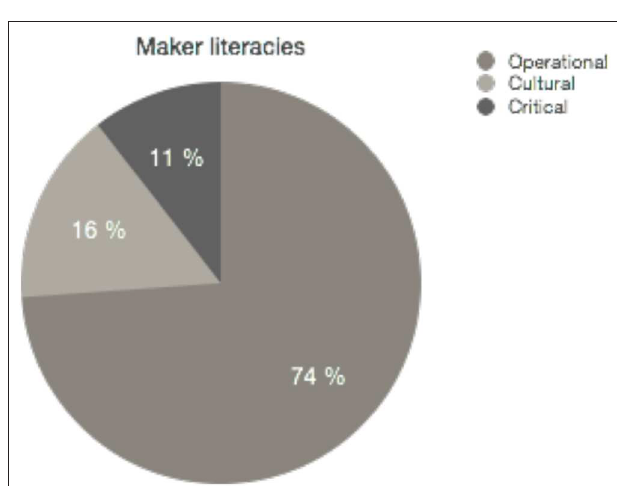
FIGURE 1 | The nature of maker literacies in the FUSE